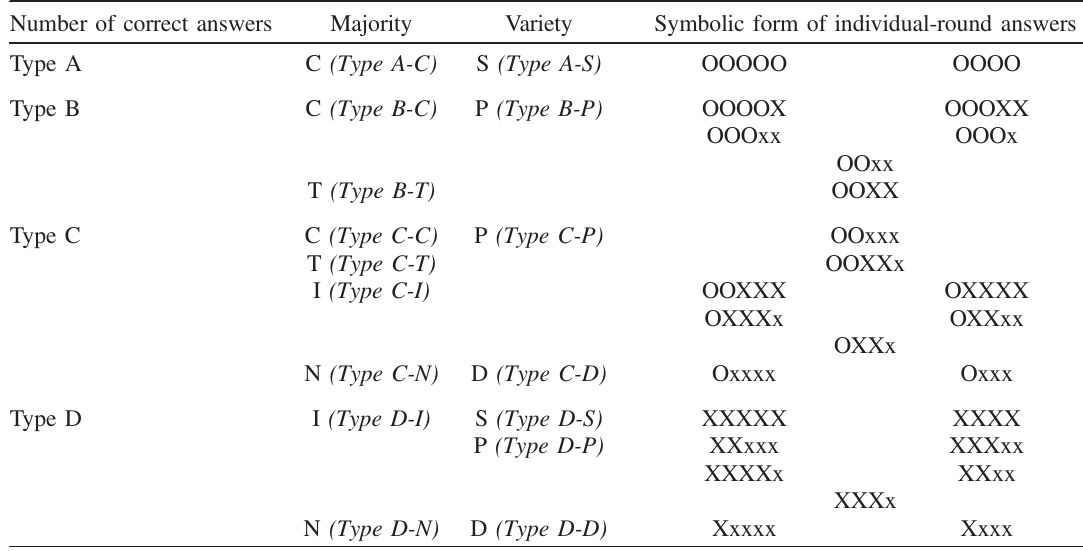
TABLE II. Group types based on individual-round performance. In the symbolic form of the individual-round answers, X is same incorrect, x is different incorrect, and O is the correct answer. Different from the group type due to the number of correct answers, group type due to a majority and variety consider “ same ” and “ different ” natures in the incorrect answers.